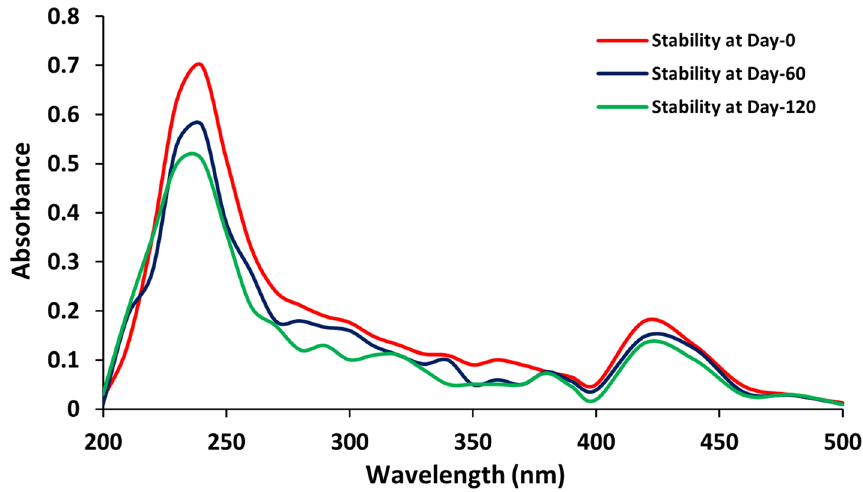
Figure 6. Long term storage stability of the developed nanocomposite system